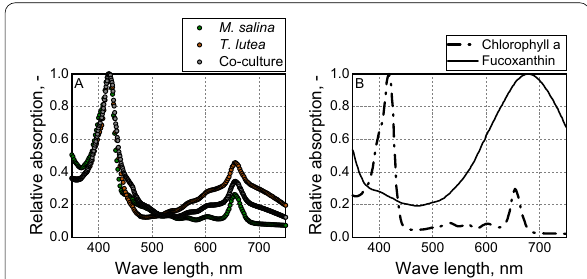
Fig. 6 A Absorption spectra of monocultures of M. salina (green dashed lines) and T. lutea (red dashed lines) and of a co‑culture (green dashed lines) of both microalgae after acid acetone extraction. B Absorption spectra of the pigments Chlorophyll a (dashed dots) and Fucoxanthin (dashed line) after acid acetone